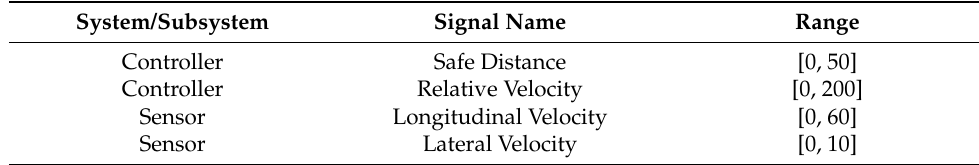
Table 3. Domain knowledge for observation